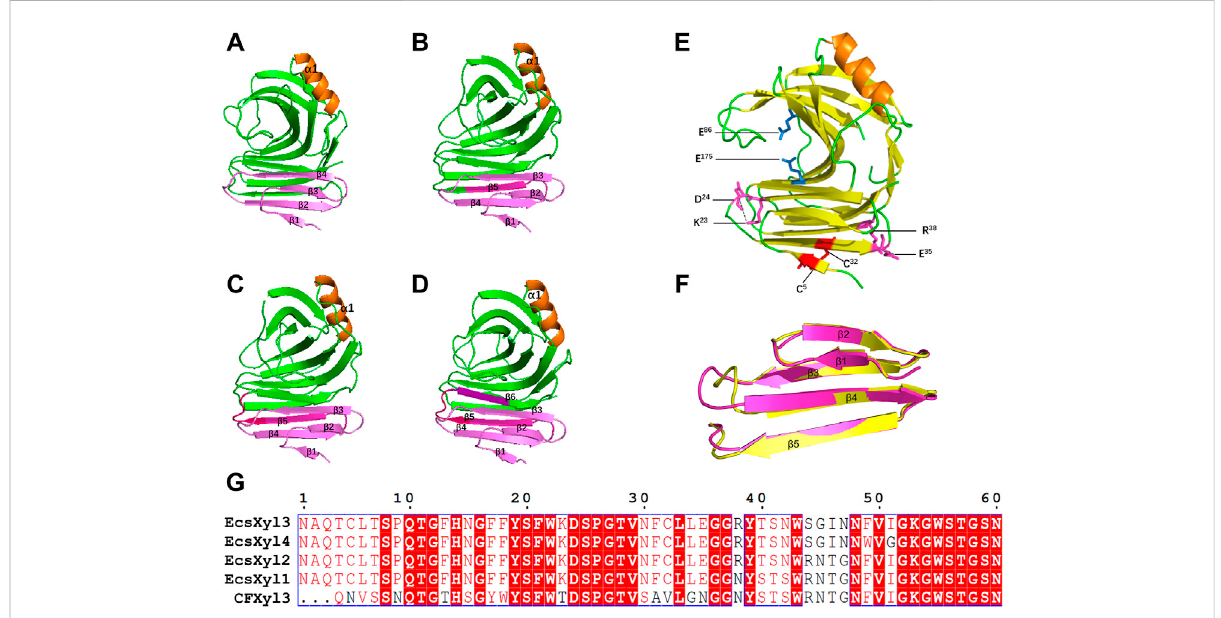
FIGURE 2 The3Dstructureanalysis ofEcsXyl1 (A) ,EcsXyl2 (B) ,EcsXyl3 (C) andEcsXyl4 (D) .Thepinkpartandpurplepartaretheaminoacidpositionofthe N-terminal substitution. (E) : The catalytic residues (Glu86 and Glu175) exist in the central part of the active area. The disul fi de bridge (Cys5 – Cys32) and salt bridges (Lys23 – Asp24 and Glu35 – Arg38) were led into CFXyl3 arose from N-terminus substitution. (F) : Stereoview of superimposed structure of the N-terminus substitution part of the CFxyl3 (yellow) and Ecxyl4 (pink). (G) : Sequence alignment of the N-terminus substitution part of the CFXyl3 and EcsXyl1 – EcsXyl4.